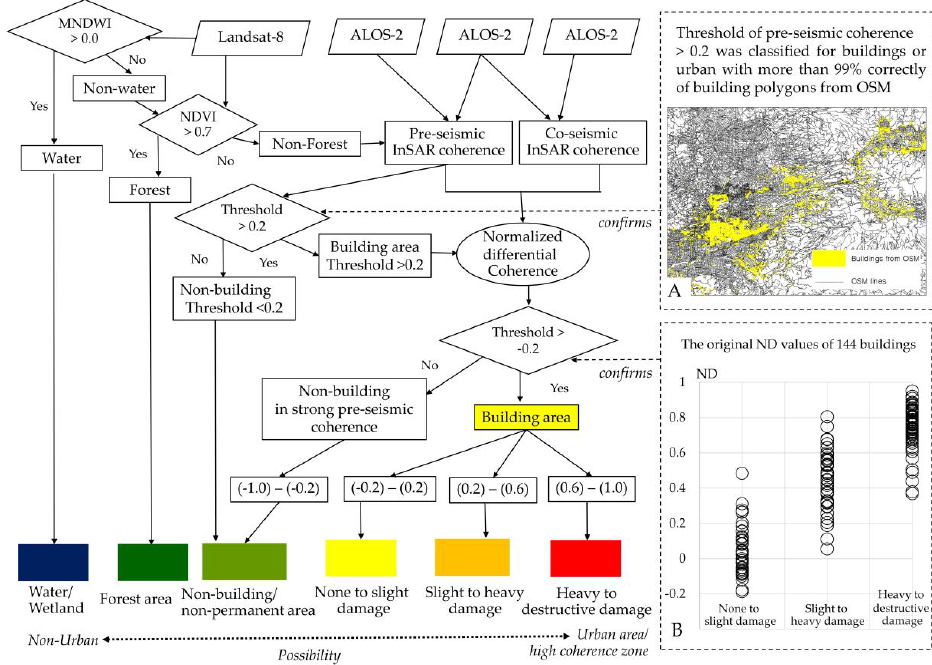
Figure 3. Classification workflow and the proposed threshold. ( A ) OSM polygons for determining threshold value of building area ( B ) the original ND values of 144 buildings for confirming ranges of damage